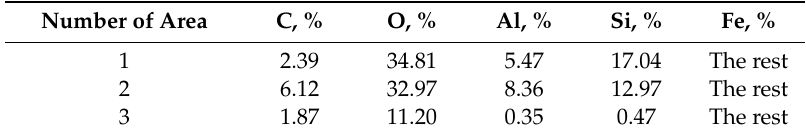
Table 7. The SEM analysis results of the FeGr1 + C + Al 2 O 3 + SiC mixture worn surface (Figure 16c, areas 1–3).